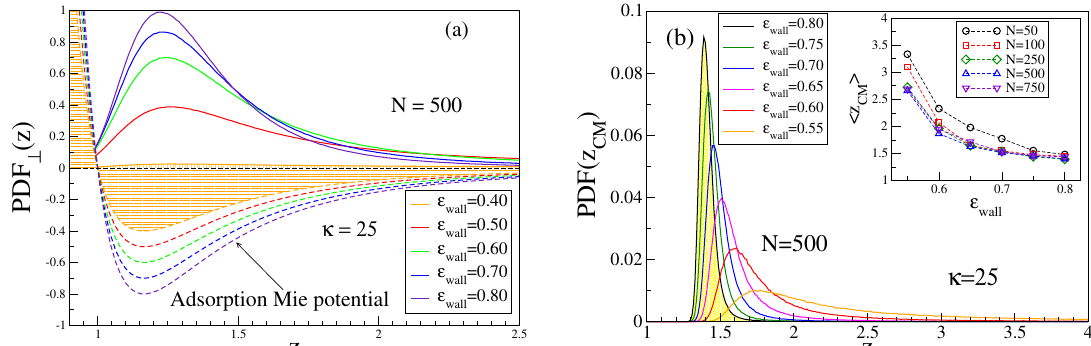
Figure 2. ( a ) adsorption Mie-potential, Equation (6)—broken curves, plotted for z and five choices of (cid:101) wall , as indicated. The corresponding monomer density distributions ρ ( z ) for N = 500, κ = 25, (cid:82) ∞ ρ ( z ) dz = 1, are indicated by full curves, ( b ) probability distribution P ( z CM ) of the normalized as 0 center-of-mass position z CM of a chain with N = 500, κ = 25, for six choices of (cid:101) wall . Weakly bound chains ( (cid:101) wall = 0.55 and 0.60) have very asymmetric distributions while strongly bound chains ( (cid:101) wall = 0.75 and 0.80) have almost Gaussian distributions with only small asymmetry in the tails, whereas the peak position exceeds z min distinctly. Inset shows the variation of (cid:104) z CM (cid:105) with (cid:101) wall for five choices of N